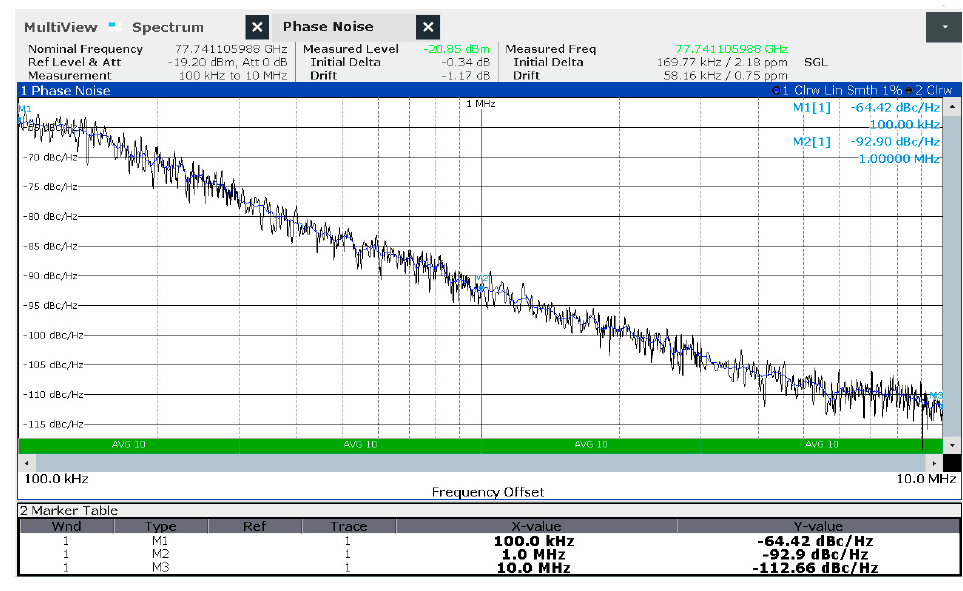
Figure 19. The measured phase noise at 77.74 GHz.